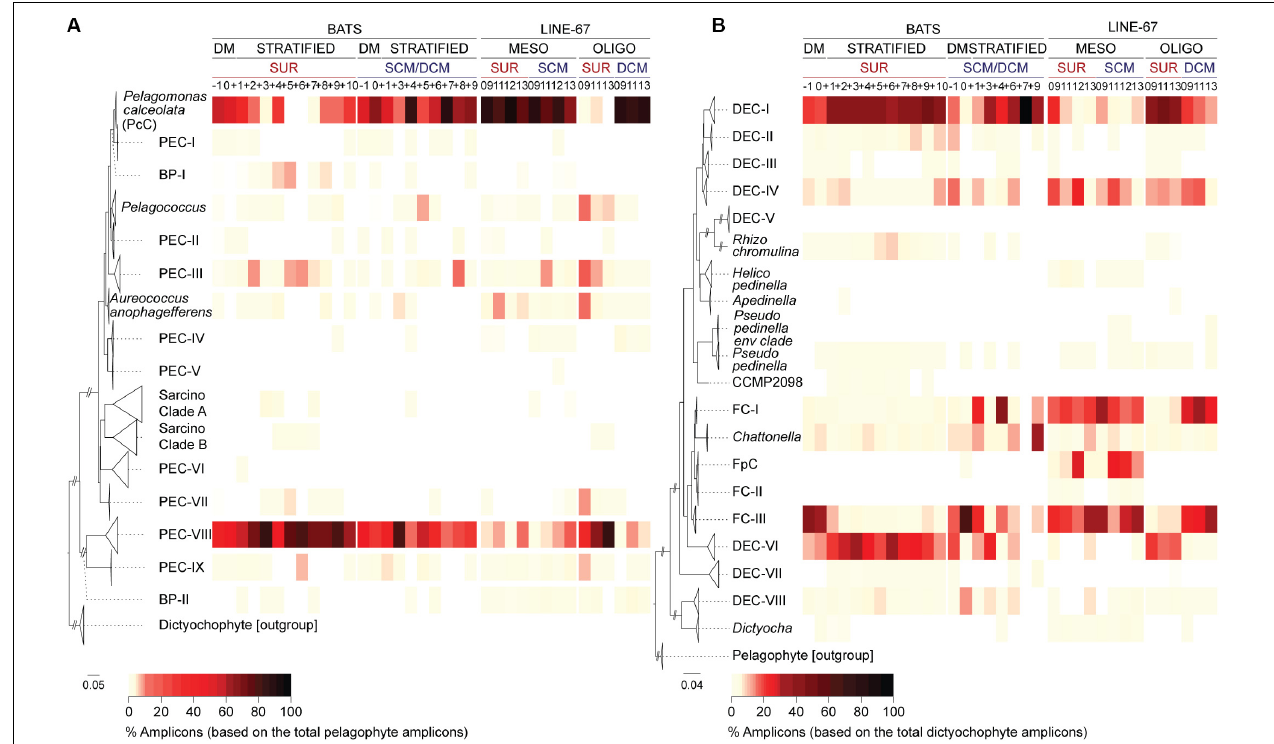
FIGURE 3 | Diversity and distributions of newly resolved dictyochophyte and pelagophyte clades at BATS and in the ENP. High-taxonomic resolution of (A) pelagophyte and (B) dictyochophyte distributions at the surface (SUR) and depth (SCM/DCM) at BATS and ENP. Reference trees to the left of each panel indicate clades. Heatmaps show the percentage of amplicons relative to those of pelagophytes (A) and dictyochophytes (B) during each BATS month or ENP samples (vertical columns; see Figure 4 for additional details on ENP samples). Bootstrap support and phylogenetic inferences are as detailed in Figure 2B and Supplementary Figure S5 . ENP samples are partitioned based on standing stock nutrient concentrations which were considered mesotrophic (MESO) or oligotrophic (OLIGO) ( Supplementary Table S5